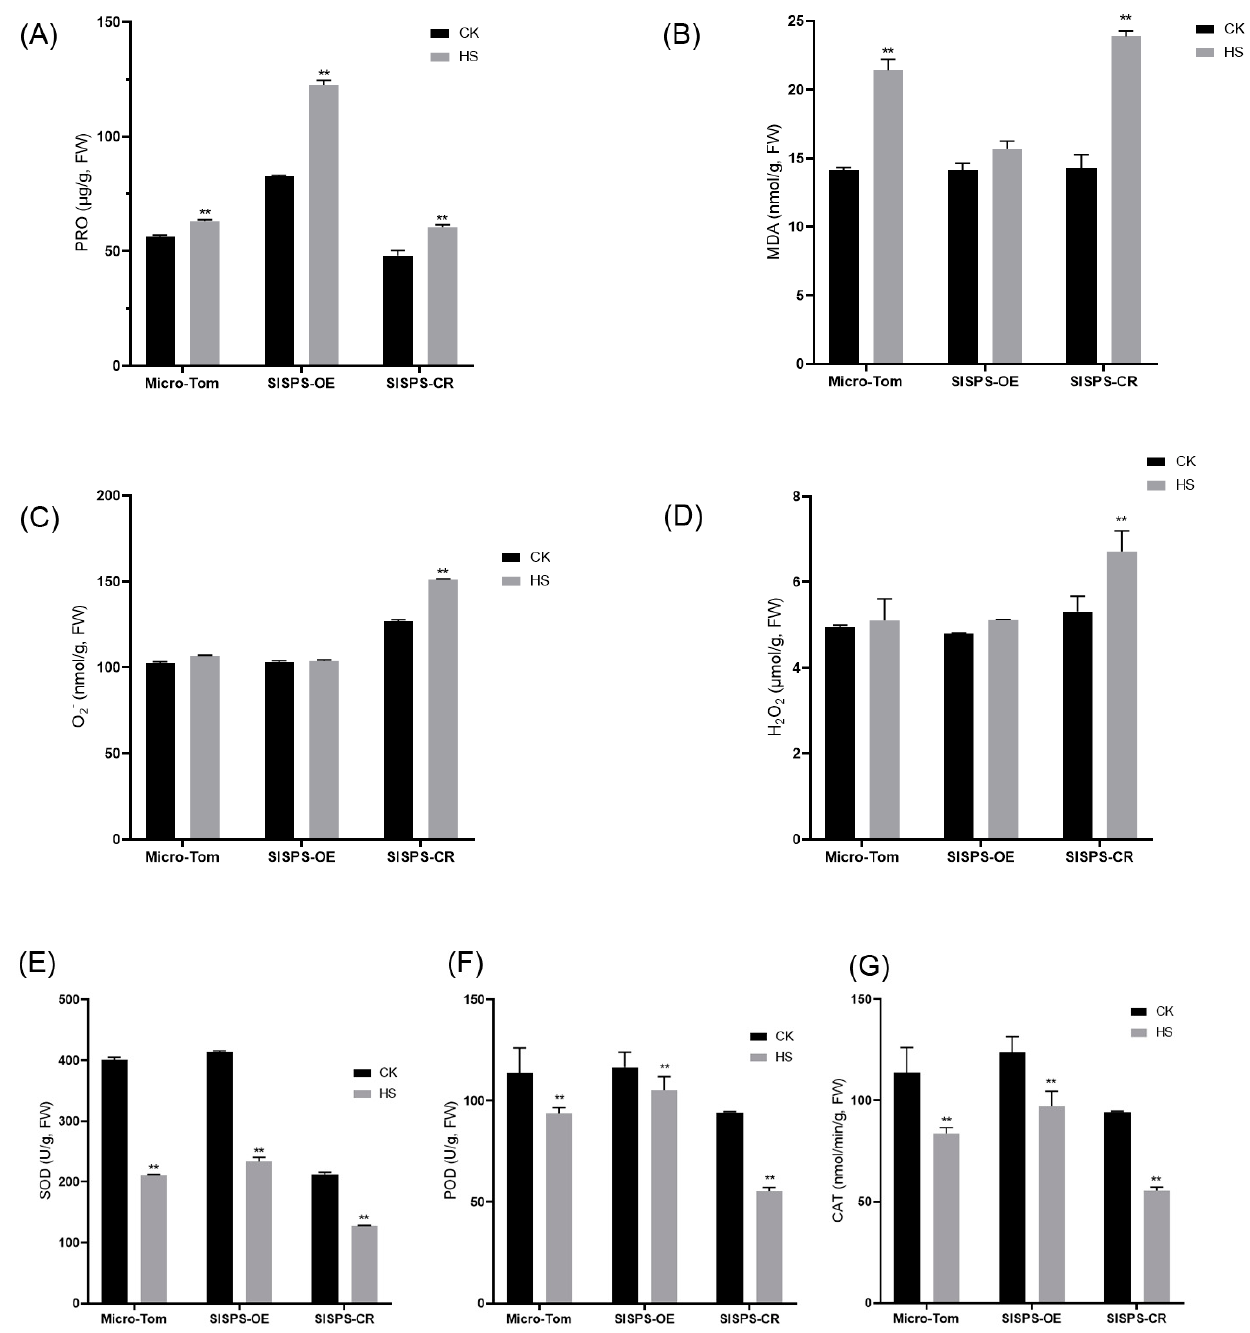
Figure 6. Reference values of oxidative stress parameters of leaves under HS treatment for 2 weeks.